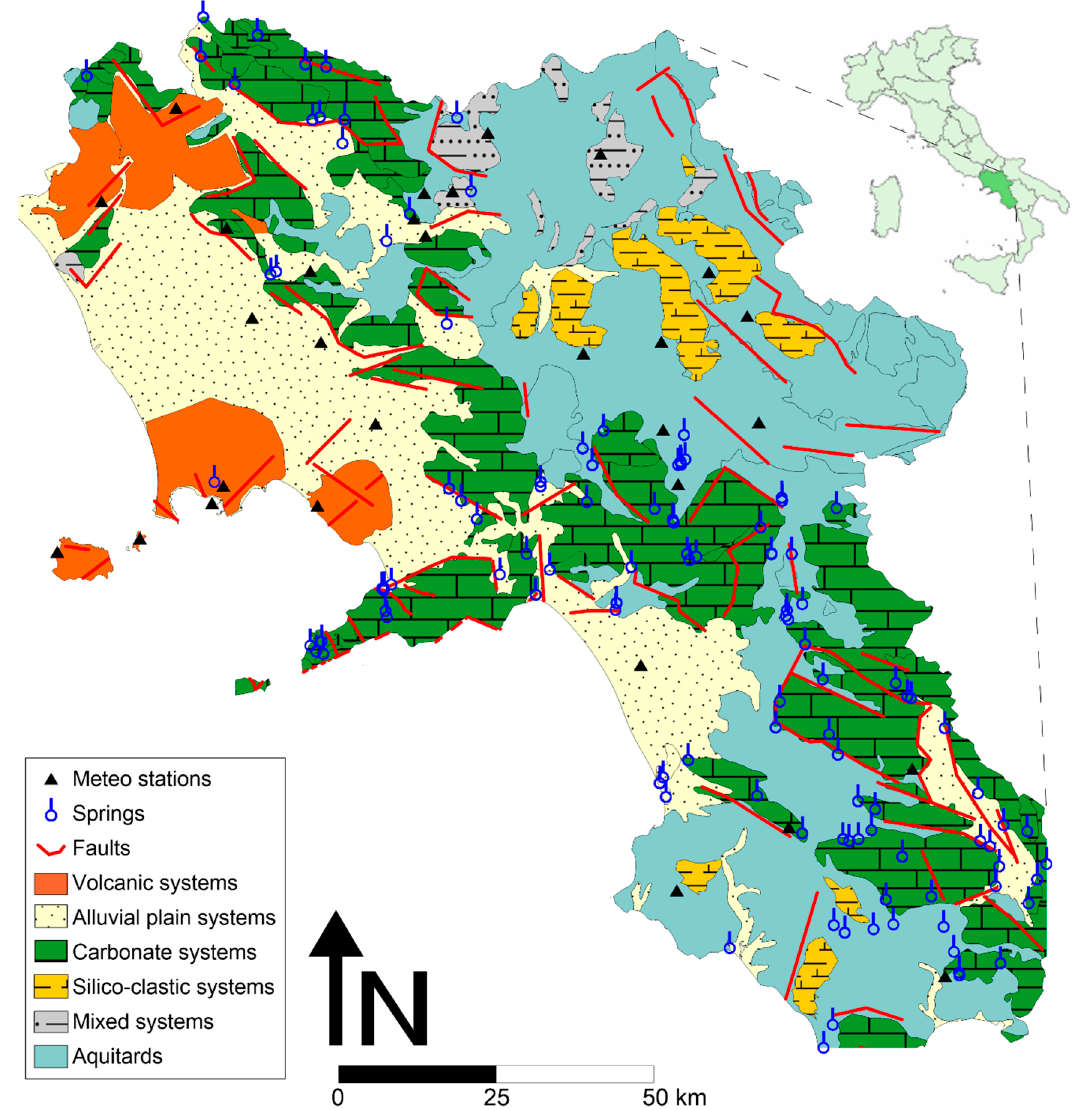
Figure 1. Hydrogeological map, with the location of the meteorological stations, the main faults and the monitored springs.